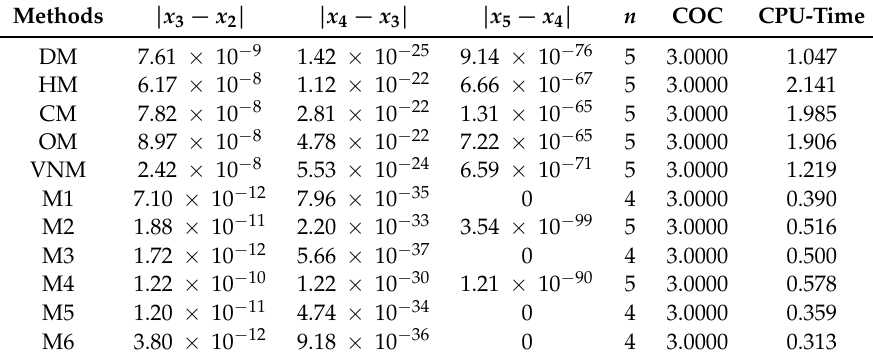
Table 4. Comparison of performance of methods for Example